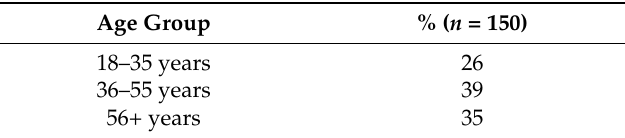
Table 1. Age composition of respondents to the KAP